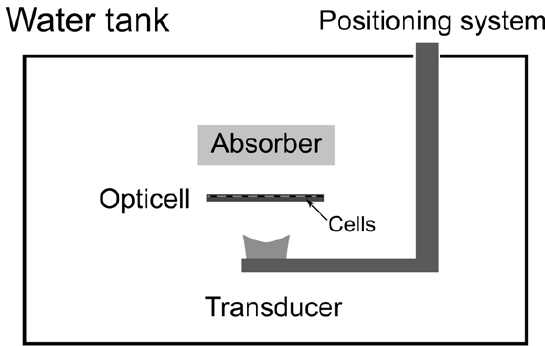
Figure 1. HIFU exposure setup. Our in-house built HIFU apparatus consisting of a motorized transducer, capable of movement in the x, y, and z planes, and a holder for the Opticell TM chamber submerged in a tank of degassed 37 u C water. The walls of the tank and the area above the transducer and Opticell TM chamber were lined with an absorptive material, to prevent reflection of the acoustic beam and resulting standing wave formation.